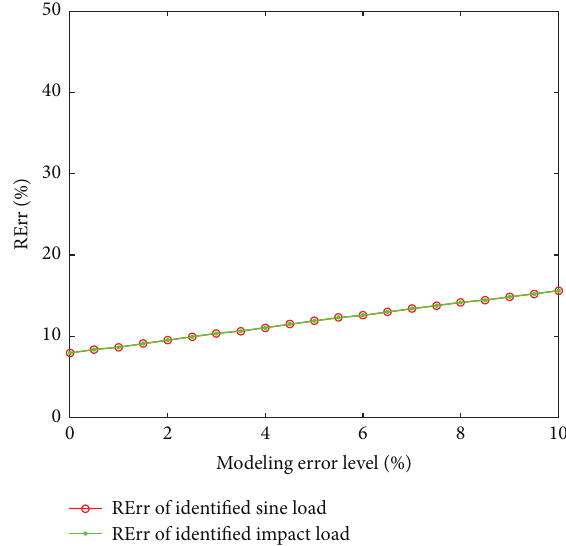
Figure 17: Identified sine load of MIMO system.